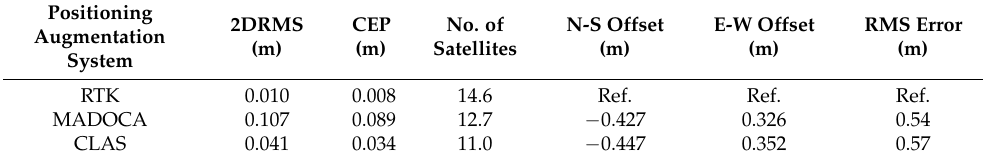
Table 3. Accuracy